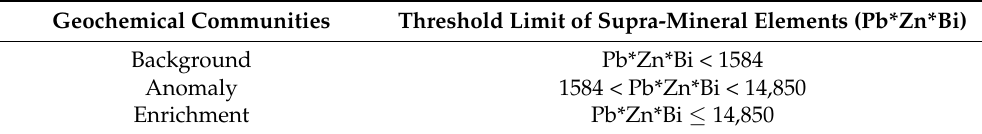
Figure 16. The prospectivity map of supra-mineral elements based on stream sediment samples.